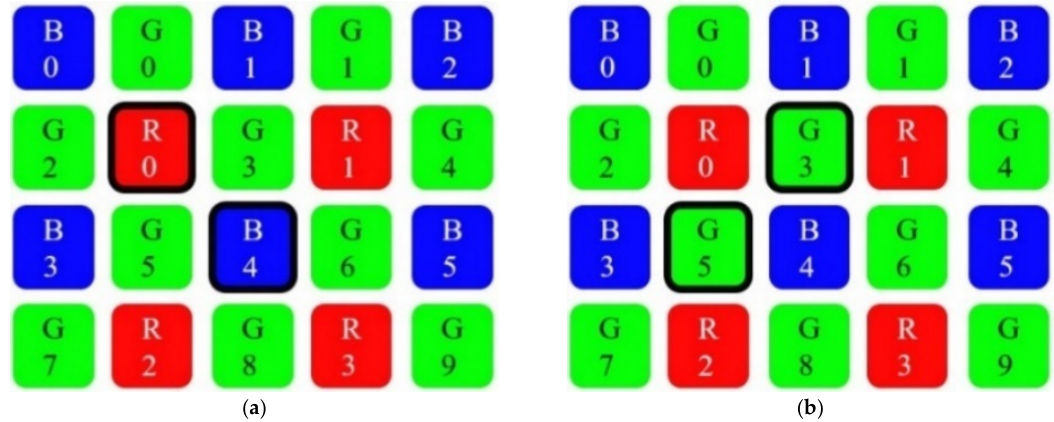
Figure 6. Pixels involved in real-time FPGA image processing: ( a ) edge-directed green color bilinear interpolation; ( b ) image sharpness value calculation from red and blue pixels. Green color interpolation was calculated at every red pixel position and at every blue pixel position. The image sharpness value was calculated at every green pixel position as a blue-gradient and red-gradient calculation. By doing this, the two image-processing operations were interleaved on a single image frame. To the best of our knowledge, the described image processing method has not yet been presented in any iris image acquisition application. Figure 6b and Equations (3)–(5) show how the green pixels’ positions are used to calculate the image sharpness of an image frame. For an image frame with 480,000 pixels, there are 240,000 pixel-sharpness calculations. Better focused images have higher image sharpness values.